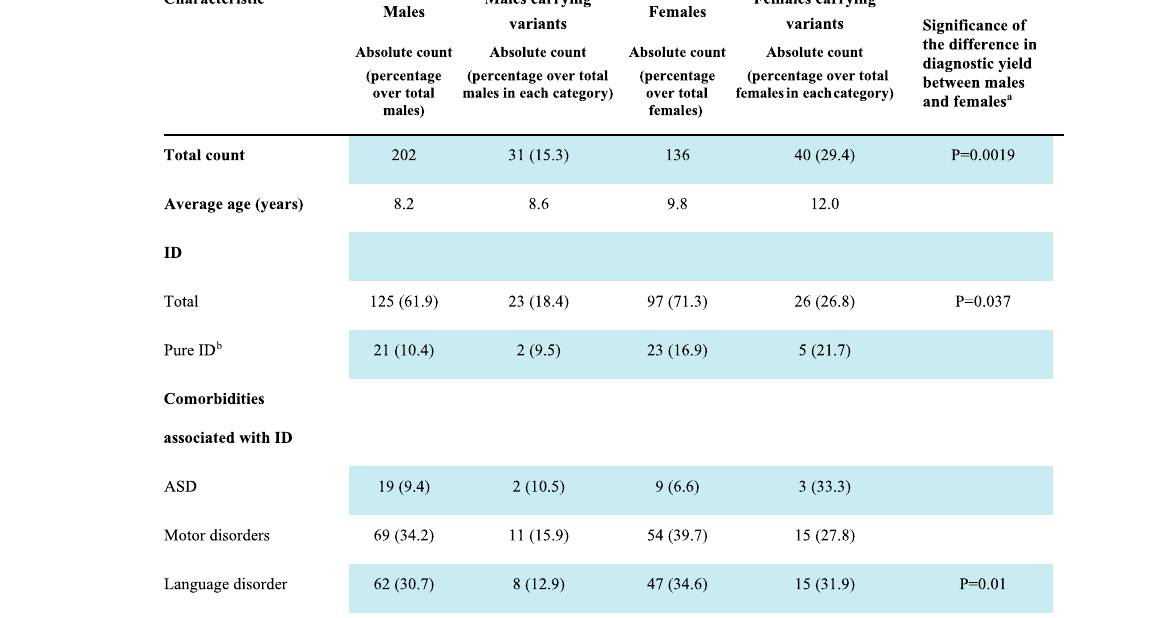
TABLE 2 | Diagnostic yield in males and